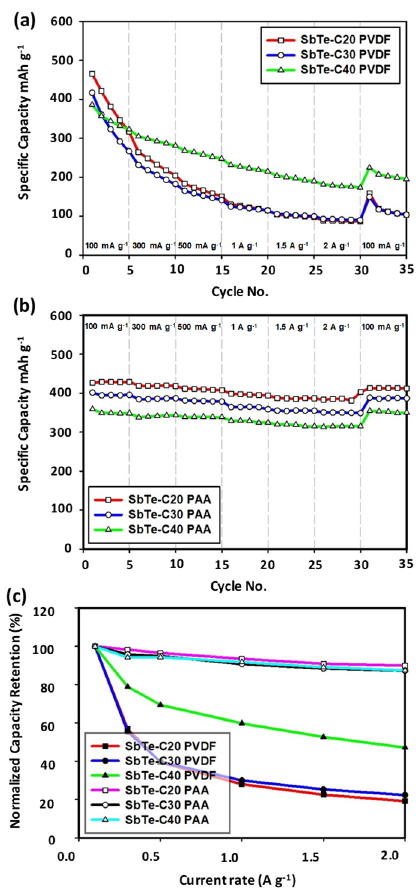
Figure 8. Rate capabilities of the SbTe-C20, SbTe-C30, and SbTe-C40 electrodes with 5% FEC added to the electrolyte and ( a ) PVDF as the binder and ( b ) PAA as the binder. ( c ) Normalized charge-capacity retentions as functions of current